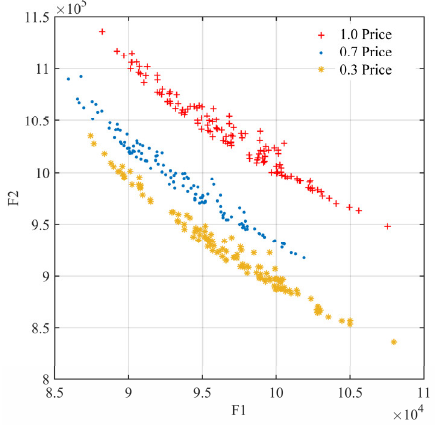
Figure 14. Price factors.